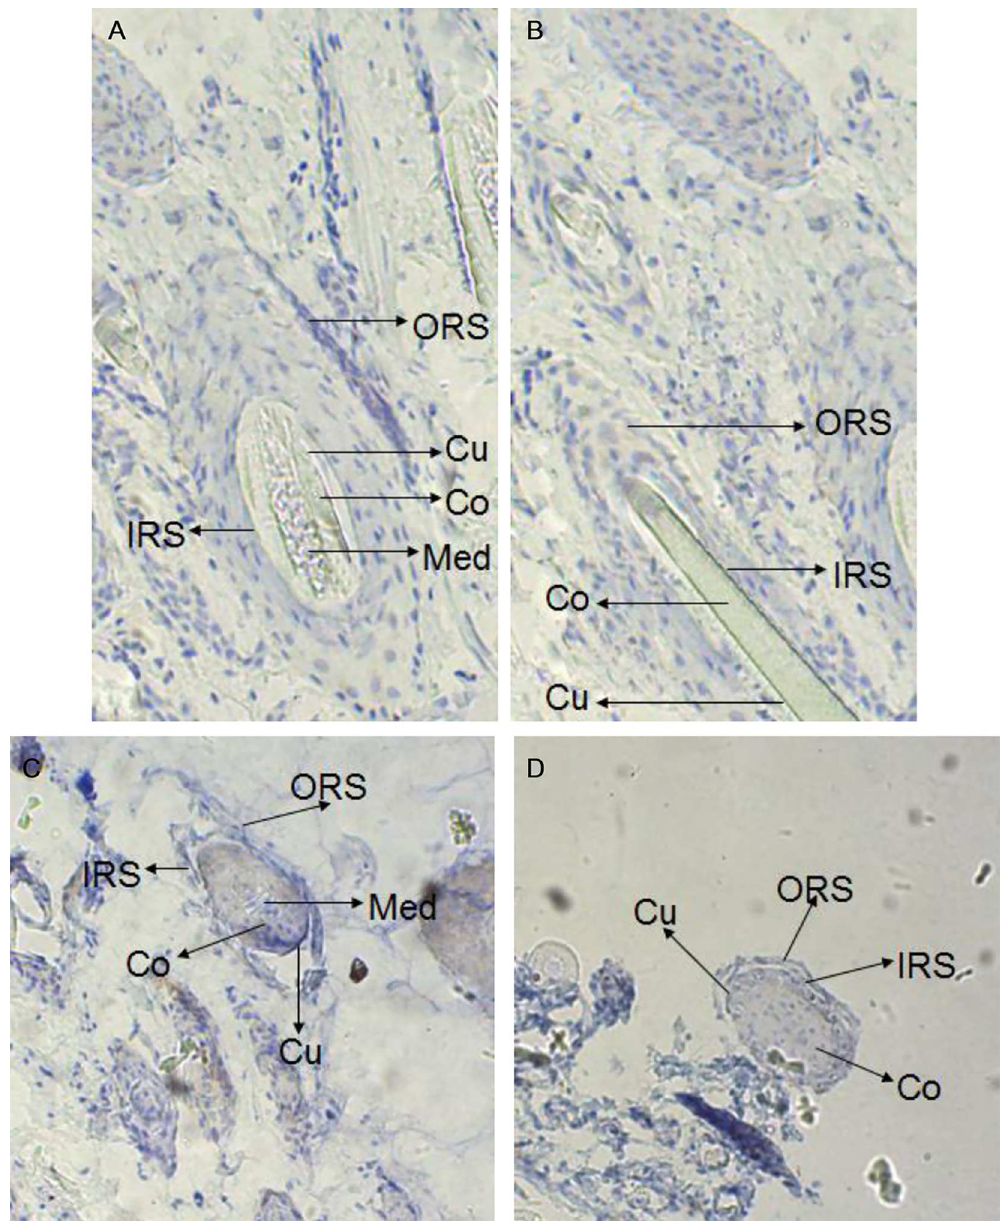
Fig 4. Expression of keratin 26 in skin was detected by immunohistochemistry in control group (100 × ). Fig 4A. Longisection of primary follicle in control group. Fig 4B. Longisection of secondary follicle in control group. Fig 4C. Transectionof primary folliclein control group. Fig 4D. Transectionof secondary folliclein control